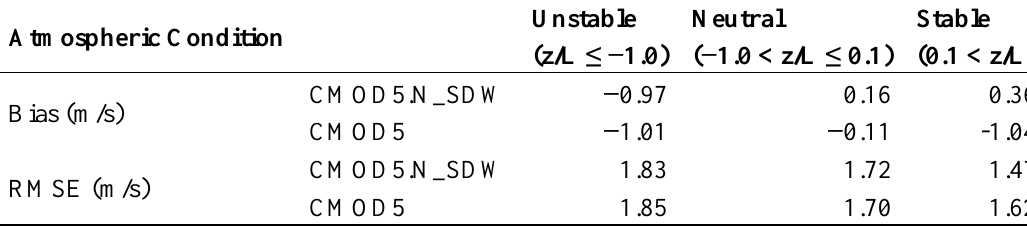
Table 3. Comparison of statistics between CMOD5.N_SDW and